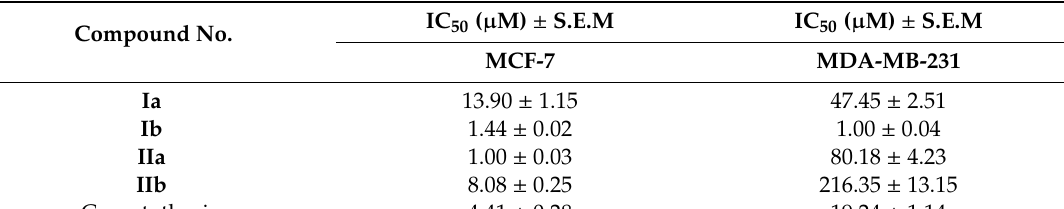
Table 1. Cytotoxicity of the intermediates Ia,b , IIa,b and camptothecin. Compound No.